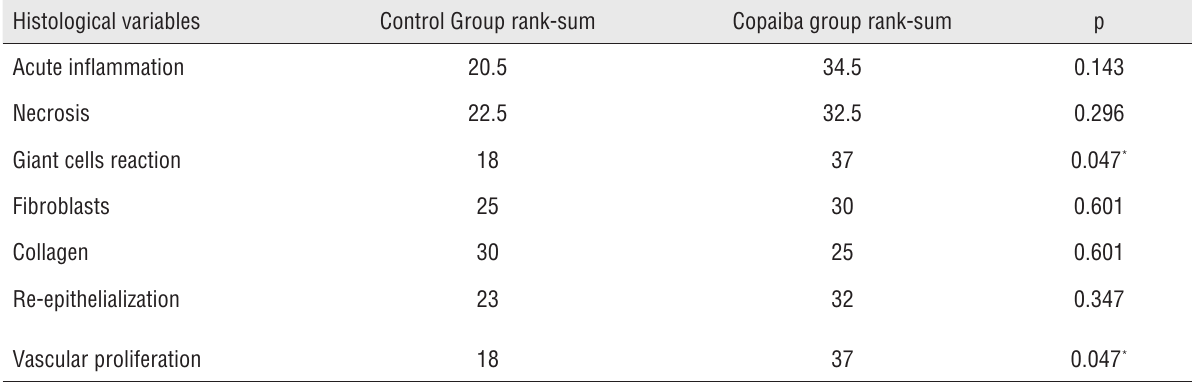
Table 3 - Statistical analysis of histological parameters by the Mann-whitney test with the rank-sums of which group and the p value. Histological variables